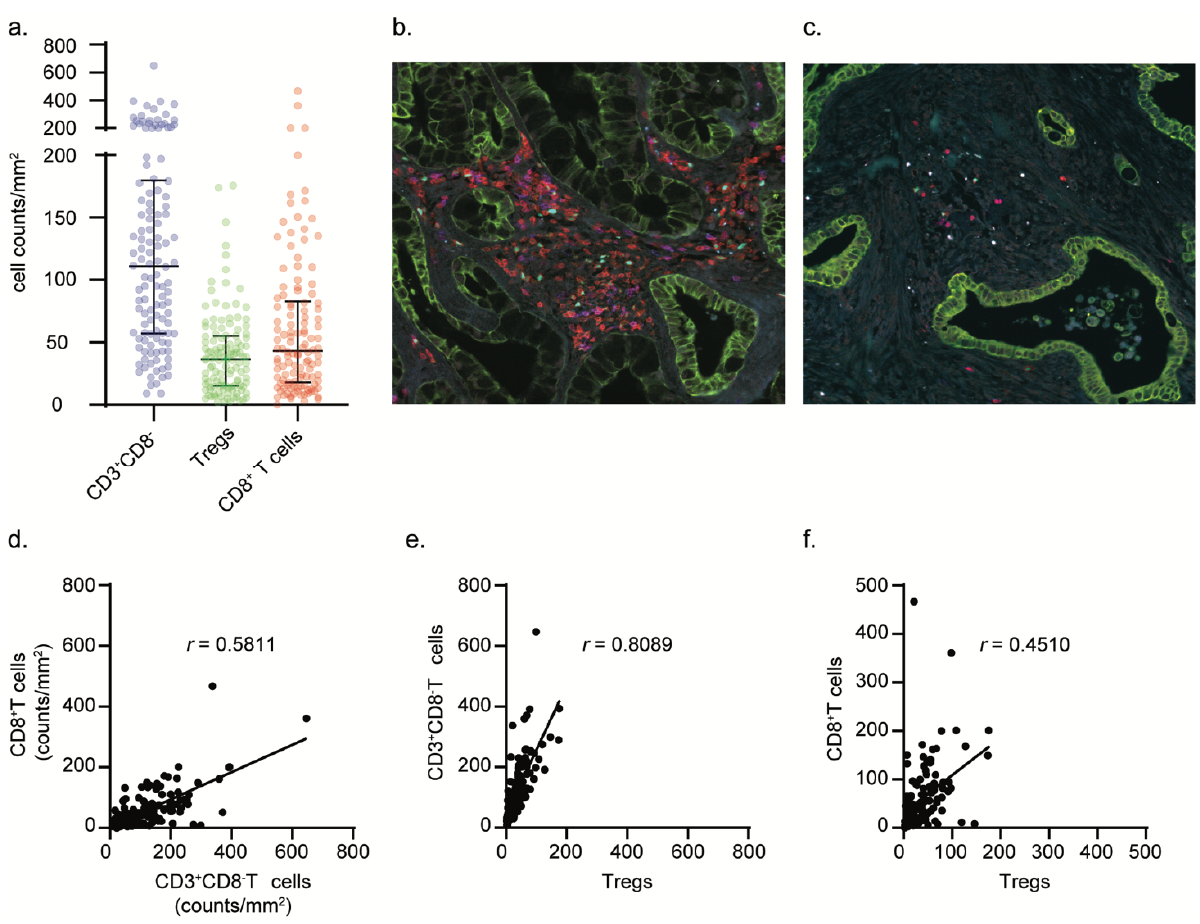
Figure 1. PDAC samples display heterogeneous amounts of T cell infiltration with CD3 + CD8 − (CD4 + ) T cells (including Tregs) being the most abundant population. Distribution and frequencies of analyzed phenotypes in PDAC samples ( a ). Representative images of the PDAC tumor microenviron- ment displaying high- and low lymphocytic infiltrate ( b , c ). Correlation analyses between cytotoxic CD3 + CD8 + T cell and CD3 + CD8 − (CD4 + ) T cell counts ( d ), CD3 + CD8 − (CD4 + ) T cell and Treg counts ( e ), and cytotoxic CD3 + CD8 + T cell and Treg counts ( f ). Spearman correlation coefficients ( r ) are pre- sented per analysis.